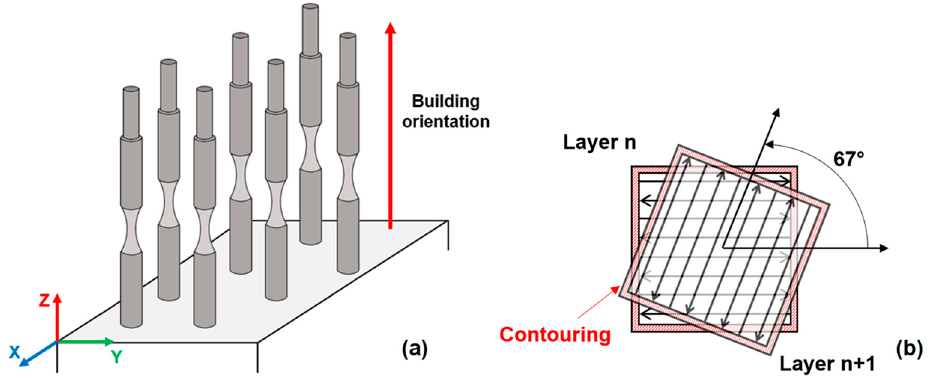
Figure 1. Printed specimens used in the experimental campaign: printing direction ( a ) (adapted from [16]); scan strategy ( b ).